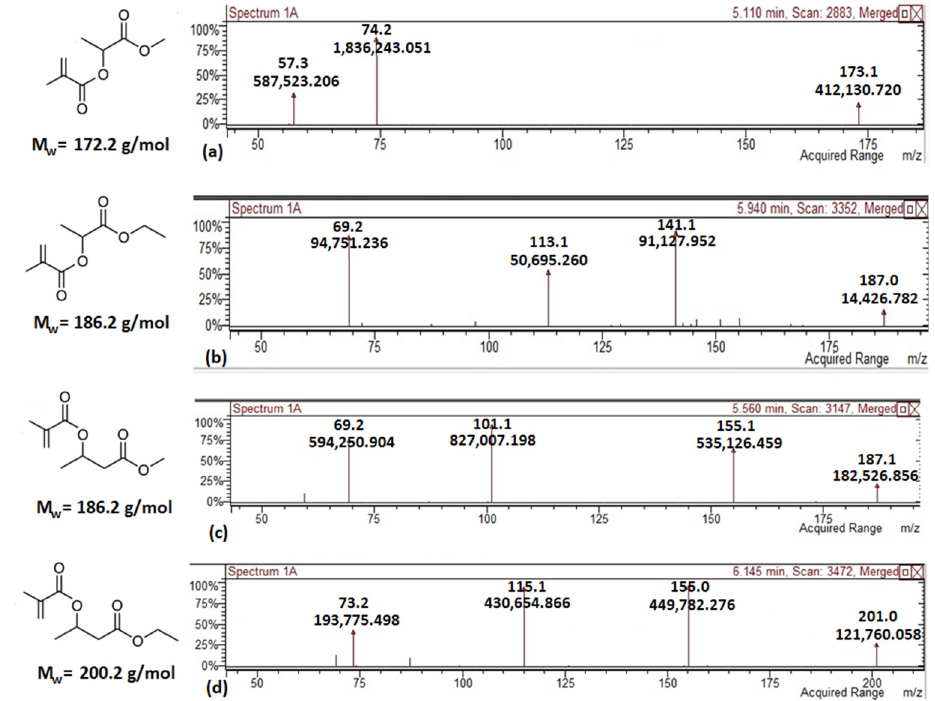
Figure 9. MS spectra of the synthesized methacrylated alkyl esters of lactic acid or 3-hydroxybutanoic acid. ( a ) Methacrylated methyl lactate (MeLaMMA); ( b ) methacrylated ethyl lactate (EtLaMMA); ( c ) methacrylated methyl 3-hydroxybutyrate (M3HB); ( d ) methacrylated ethyl 3-hydroxybutyrate (E3HB).